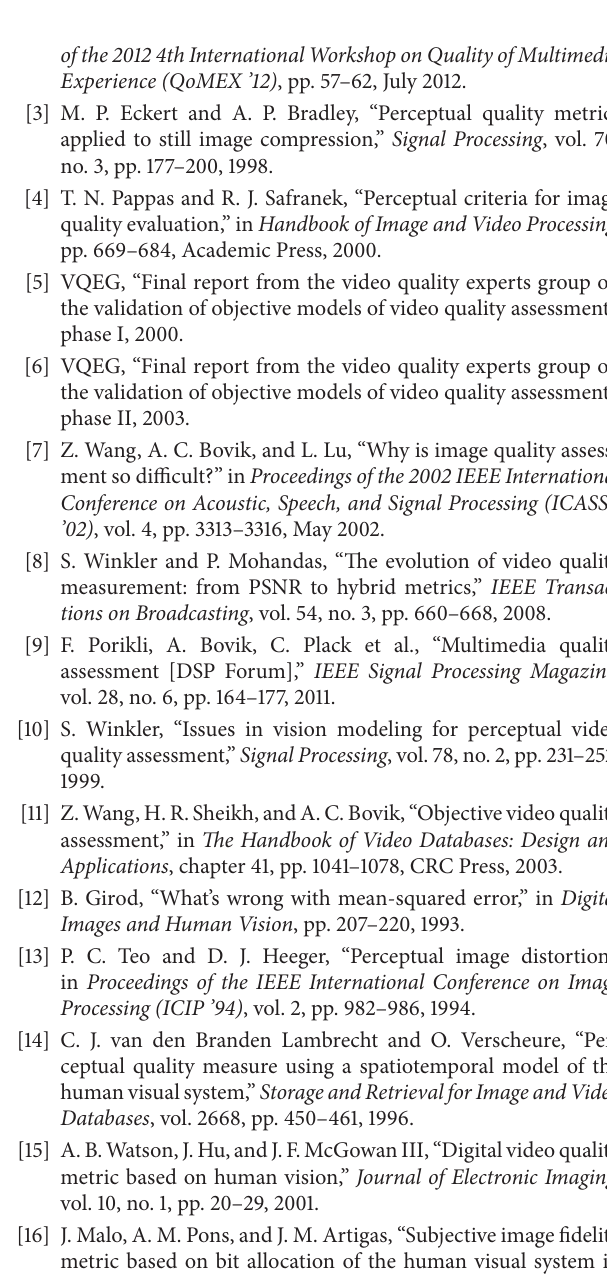
Figure 17: Decoded frames between two consecutive bursts: (a) original frame; reconstructed frames (b) 361 and (c)